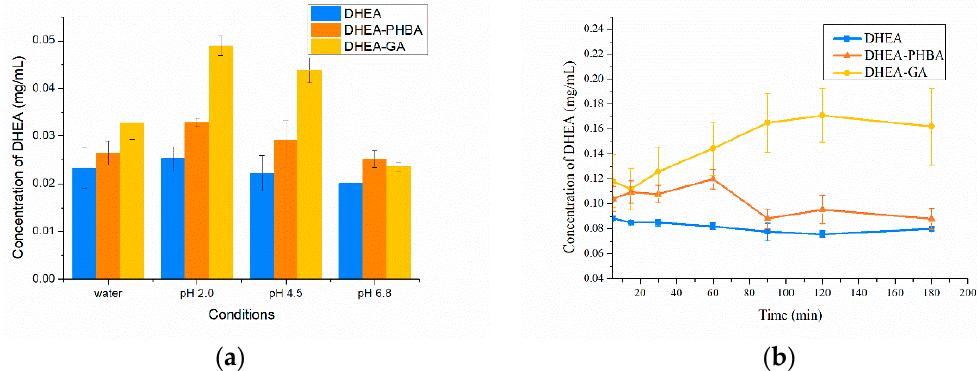
Figure 10. ( a ) Comparison of solubility of DHEA, DHEA-PHBA, and DHEA-GA under different conditions and ( b ) Comparison of solubility and dissolution performance of DHEA, DHEA-PHBA, and DHEA-GA under different